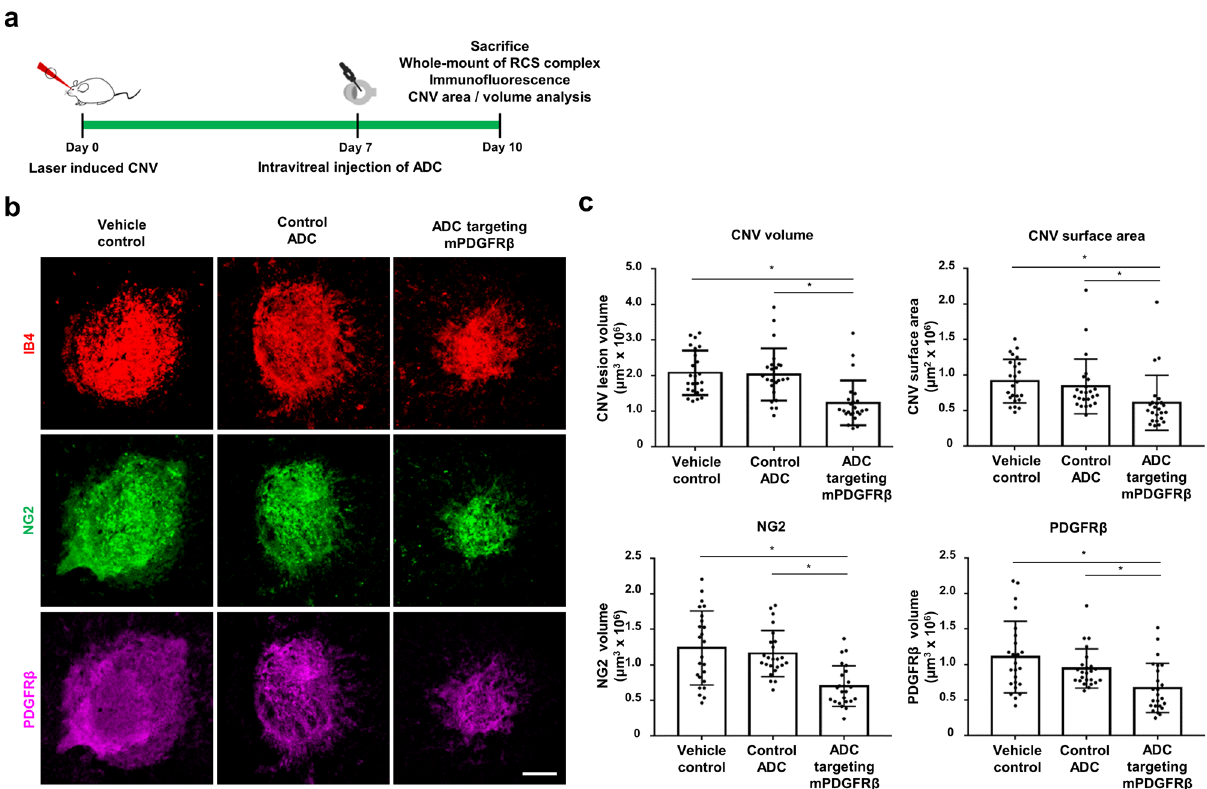
Fig. 4 ADC targeting mPDGFR β inhibits laser-induced CNV. a Schematic experimental timeline of ADC administration and tissue preparation in the laser induced-choroidal neovascularization (LI-CNV) mouse model. Six-week-old wild-type C57BL/6J male mice received laser photocoagulation and were treated with vehicle control, control antibody-drug conjugate (ADC), or ADC targeting mouse platelet-derived growth factor receptor β (mPDGFR β ) through intravitreal injection at 7 days. Three days after treatment, the mouse eyeballs were dissected, and RPE-choroid-scleral (RCS) complexes were whole mounted. Phosphate-buffered saline (PBS) was used as the vehicle control. Anti-human epidermal growth factor receptor-2 (HER2) × cotinine complexed with cotinine-duocarmycin was used as a control ADC; anti-HER2 scFv was derived from trastuzumab. b Representative images of CNV at 10 days after laser photocoagulation and immunostaining with isolectin B4 (IB4), neural/glial antigen 2 (NG2), and PDGFR β . Scale bar, 200 μ m. c Quantitation of CNV volume, CNV area, NG2 volume, and PDGFR β volume. All quantitative data were measured using the built-in tools, the LAS X systems (Leica Microsystems, Wetzlar, Germany). Each value represents the mean ± standard error mean (SEM, n = 6 mice for each group set). * P < 0.01, obtained using one-way analysis of variance (ANOVA) and Tukey ’ s post-hoc tests. Source data are provided as a Supplementary Data fi